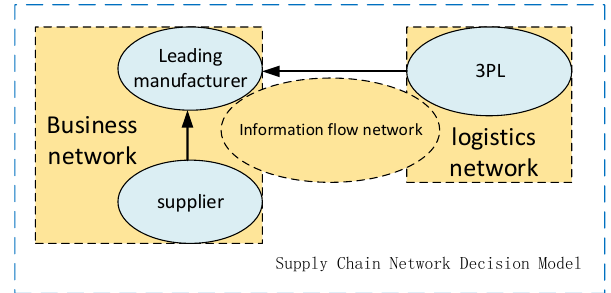
Figure 1. Supply chain network decision model considering a green index.